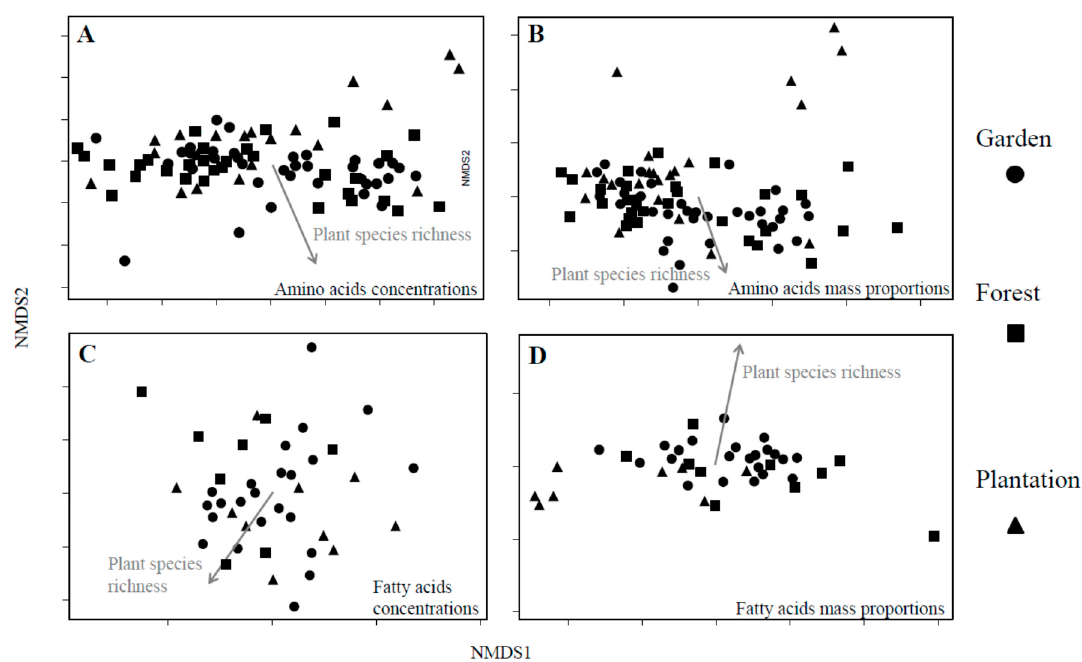
Figure 2. Similarities in the chemical composition of amino acids ( A , B ) and fatty acids ( C , D ) in larval provisions of Tetragonula carbonaria colonies placed in three different habitats (gardens (circles), forests (squares) and plantations (triangles)) and in relation to surrounding plant species richness (grey arrow). Graphs show ordination plots of non-metrical multi-dimensional scaling (NMDS) based on Bray–Curtis distances between samples expressed as concentrations ( A , C ) and mass proportions ( B , D ) of amino acids and fatty acids. Stress values: A 0.096, B 0.135, C 0.187, D 0.025.